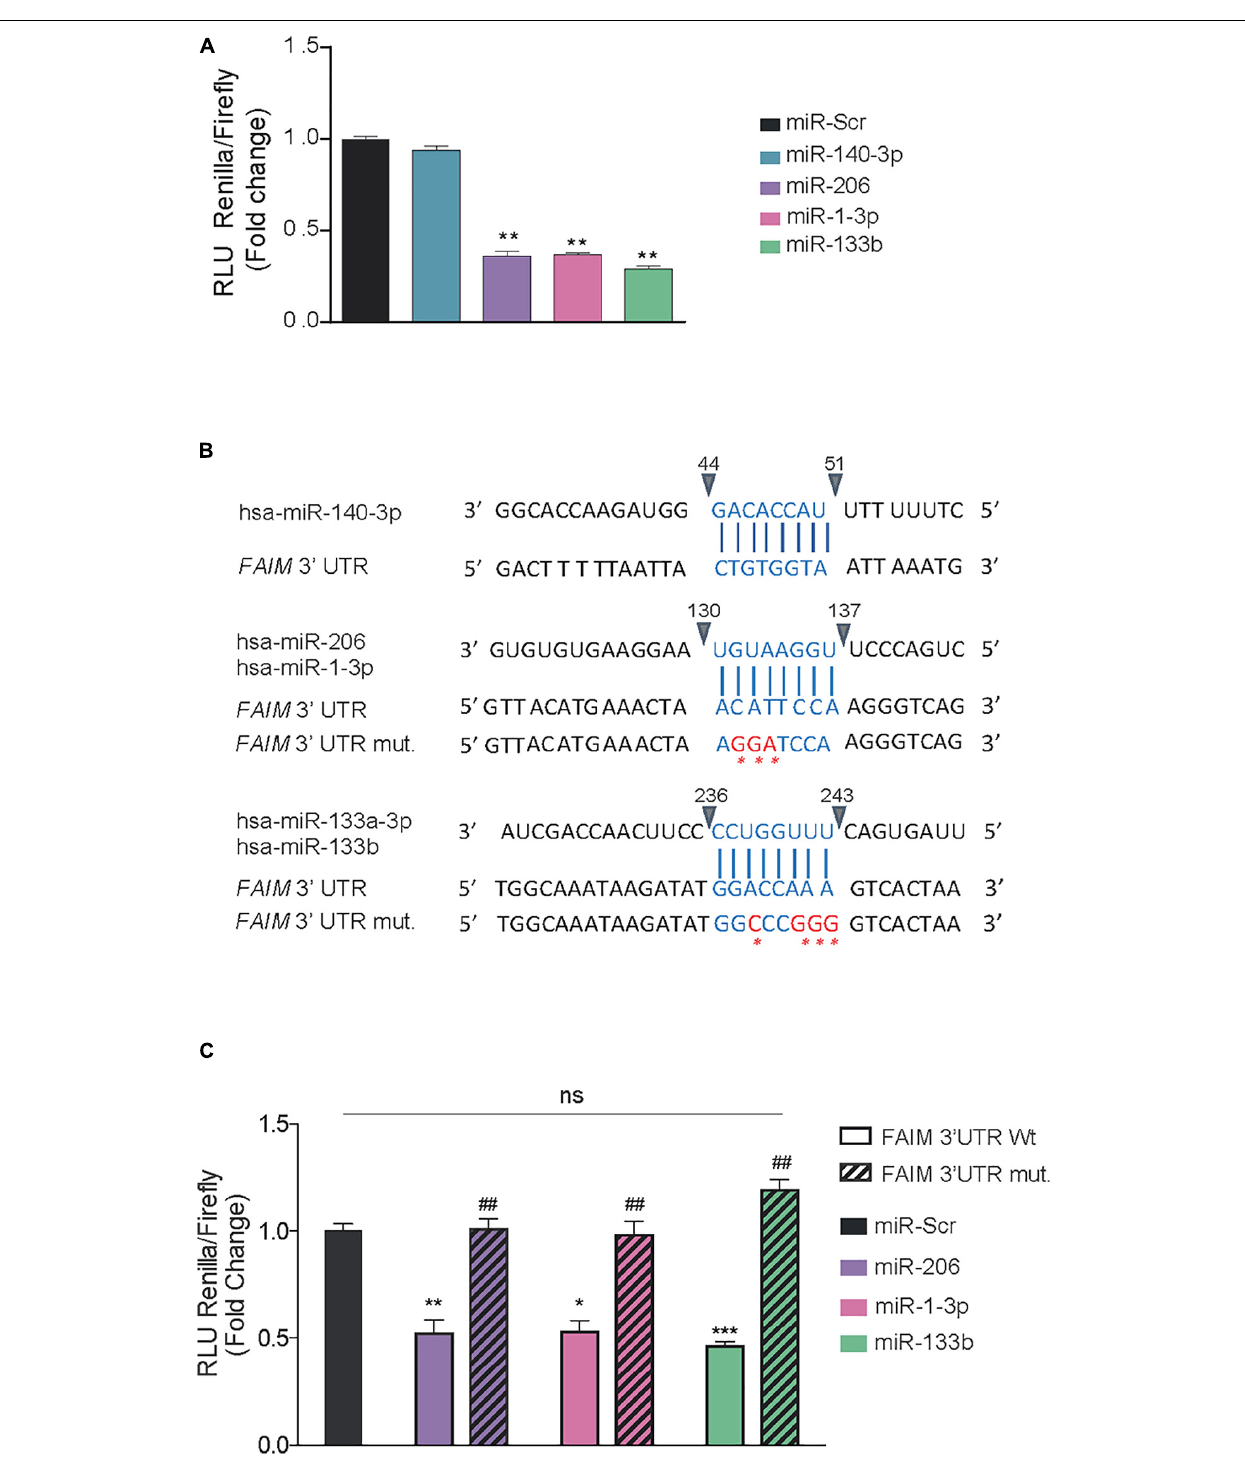
Frontiers in Cell and Developmental Biology |